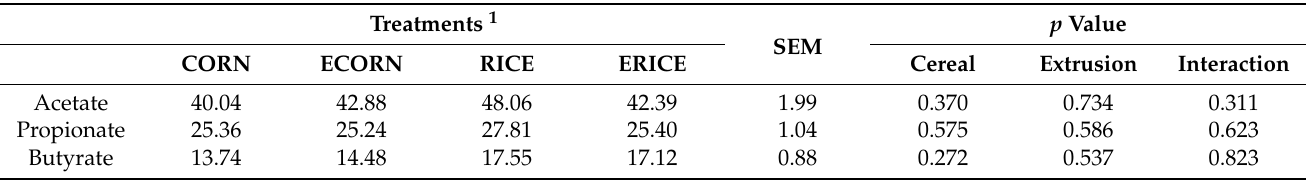
Table 6. Effects of cereal types and extrusion processing on the fecal concentrations of SCFA (mmol/L) of weaned piglets.